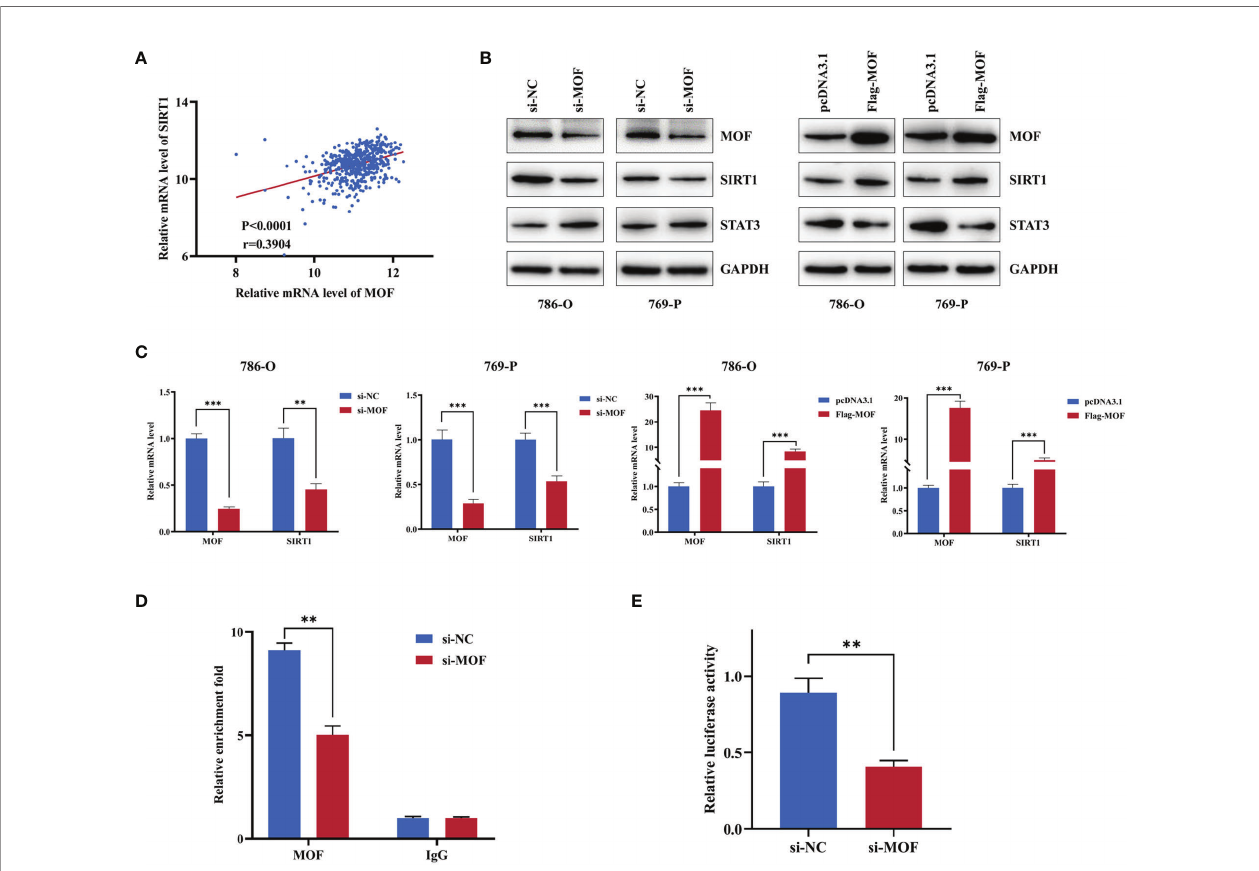
FIGURE 4 | MOF regulates SIRT1 in renal cell carcinoma cells. (A) The expression of MOF was positively associated with the expression of SIRT1 based on TCGA database. (B, C) The effect of MOF on the protein (B) and RNA (C) expression levels of SIRT1 and its target genes were detected. (D) ChIP assay indicated that MOF could bind with the promoter of SIRT1. (E) Luciferase assay showed that MOF knockdown decreased the SIRT1 promoter activity. (**, p < 0.01, ***, p <